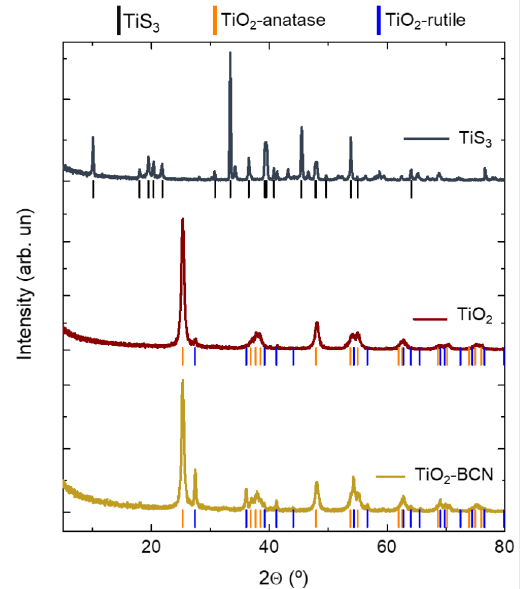
Figure 2. X-ray diffraction patterns for TiS 3 , TiO 2 and TiO 2 -BCN samples. TiS 3 peaks correspond to JDPDF 00-015-0783, TiO 2 -anatase peaks correspond to JDPDF 01-071-1167, and TiO 2 -rutile peaks correspond to JDPDF